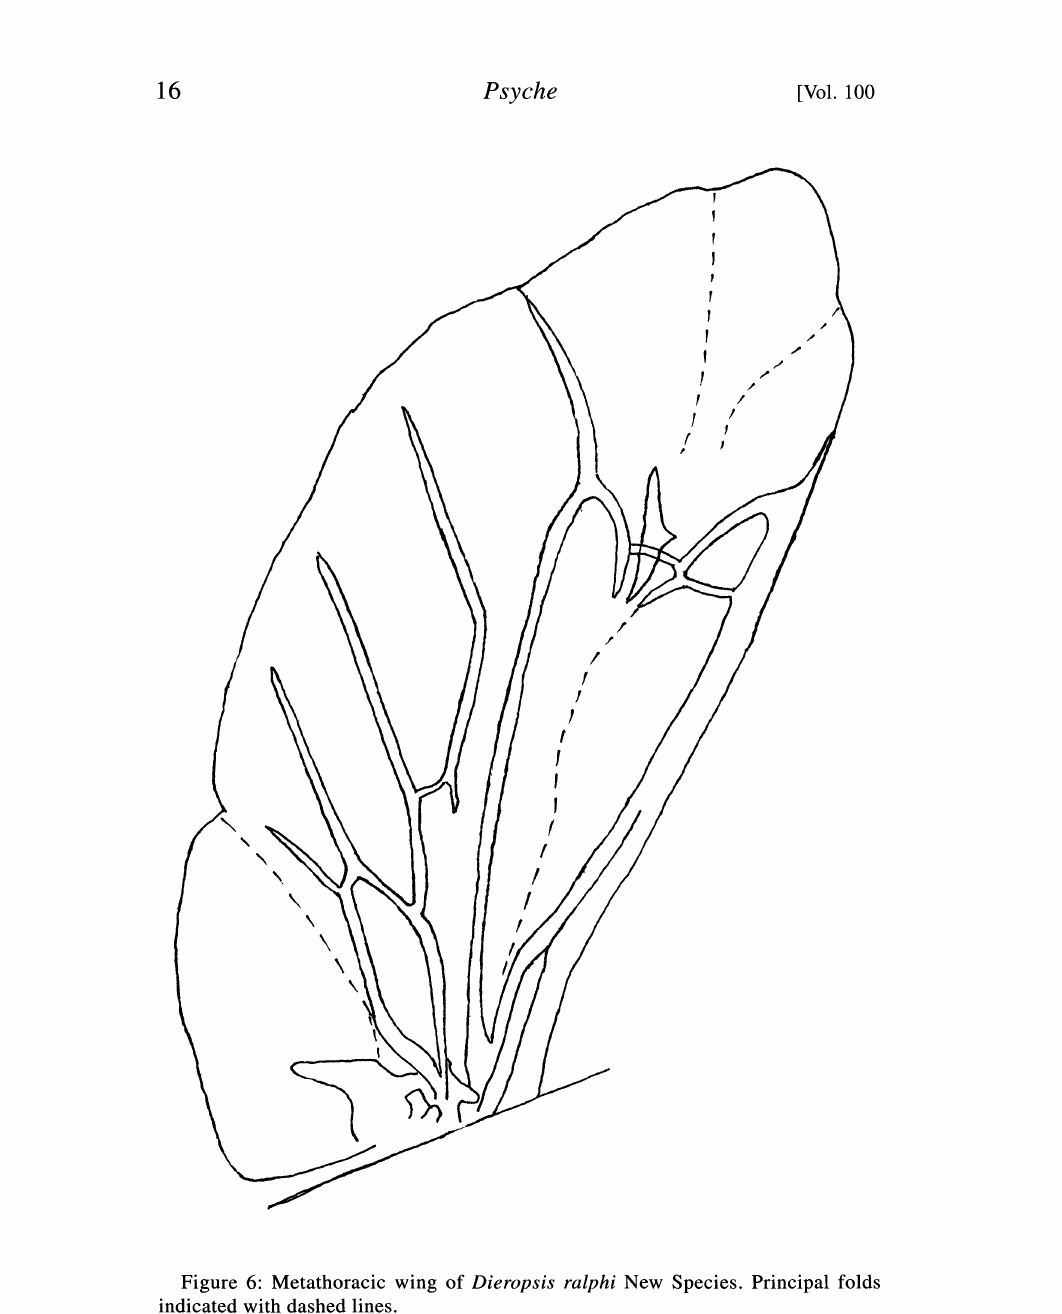
Figure 6" Metathoracic wing of Dieropsis ralphi New Species. Principal folds indicated with dashed